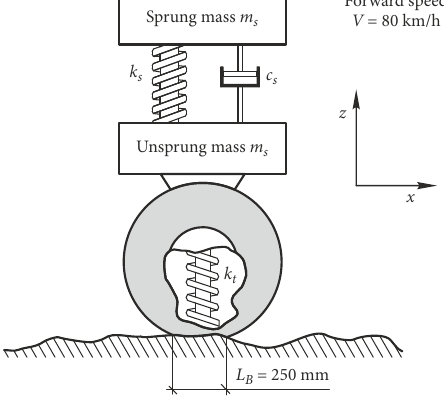
Figure 1. Quarter-car model (Sayers 1995)